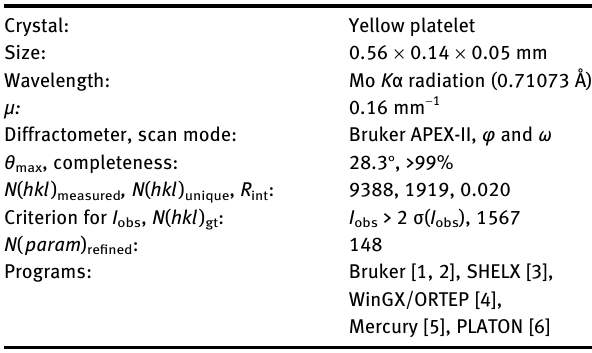
Table  : Data collection and